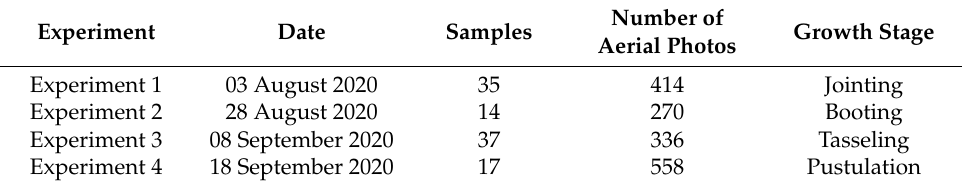
Table 1. Summary of field